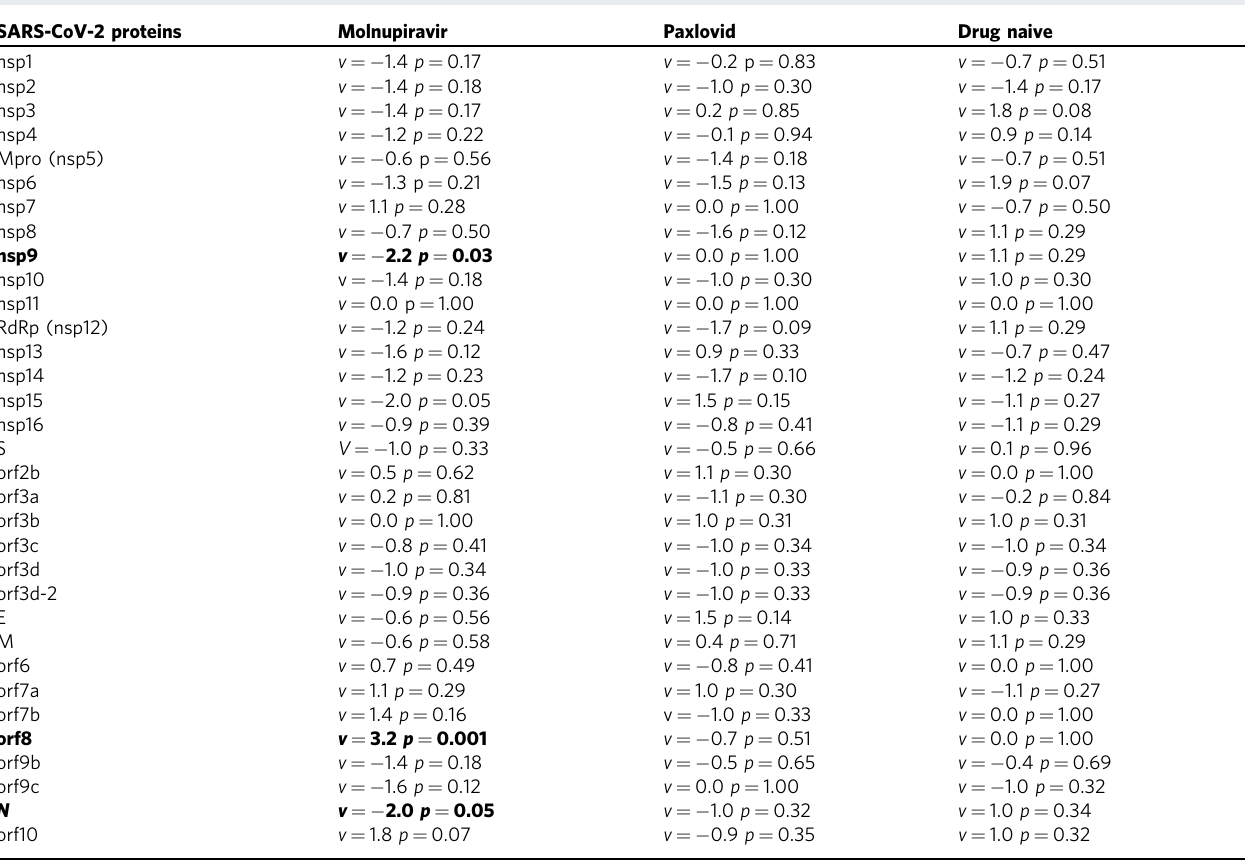
Table 3 Codon-based Neutrality for each SARS-CoV-2 gene against study groups. SARS-CoV-2